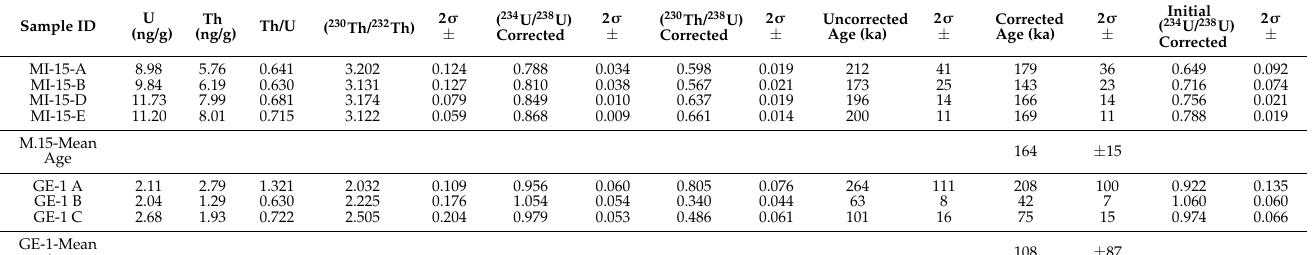
Table 1. U–Th results and calculated ages of samples MI-15 (4 repetitions) and GE-1 (3 repetitions) from the Giant Gypsum Geode. We used a mathematical correction in which the U–Th isotopic composition of the detrital contamination was arbitrarily estimated, in a manner resembling the approach by Ludwig and Paces [12]. 232 Th was used as index for the correction and assumed a typical crustal Th/U ratio of 3.5 (atomic ratio), with 234 U/ 238 U and 230 Th/ 238 U activity ratios near secular equilibrium. In our model, we specifically used the initial activity ratios 232 Th/ 238 U = 1.21 ± 50%, 234 U/ 238 U = 1 ± 10% and 230 Th/ 238 U = 1 ±